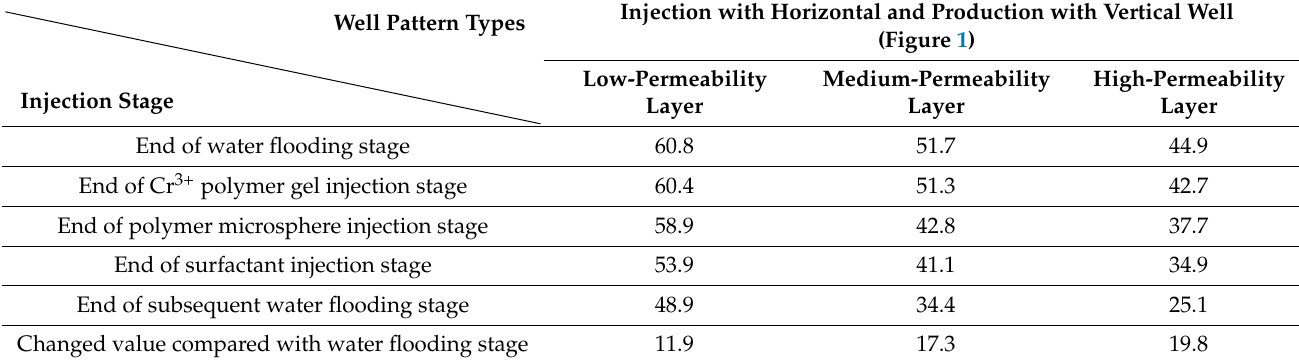
Table 6. The remaining oil saturation (%) results of Figure 1.